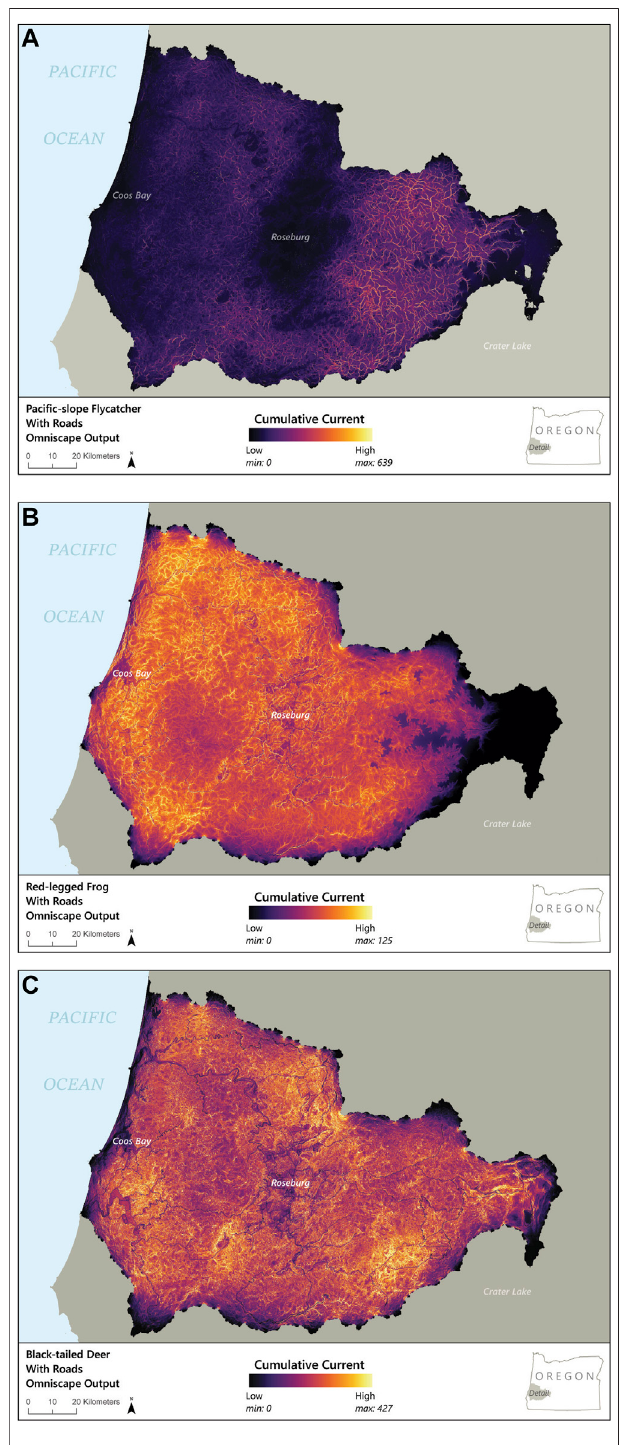
FIGURE4| Maps ofOmniscape-modeled connectivityacrossthe entire studyarea,withroads included for (A) Paci fi c-slope fl ycatcher, (B) red-legged frog, and (C) Columbian black-tailed deer. Black and purple represent low current fl ow and connectivity, whereas yellow represents high modeled current fl ow and therefore